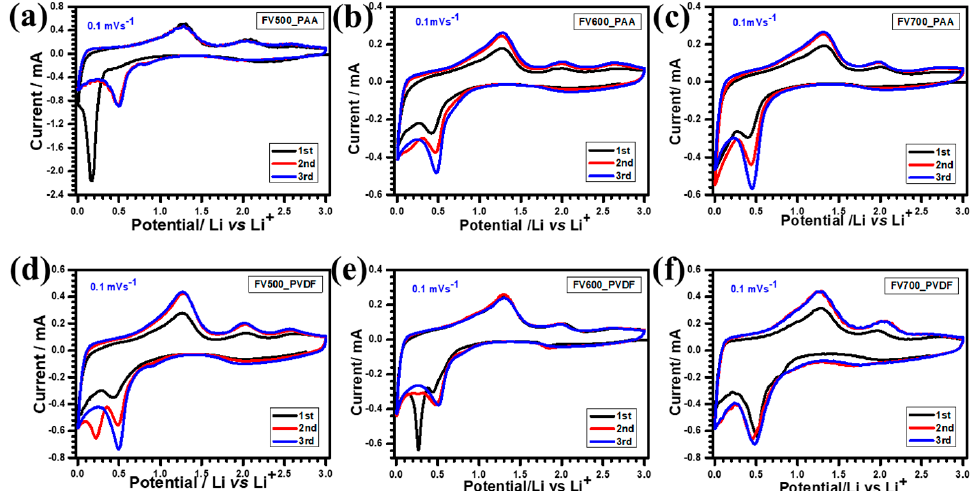
Figure 5. Cyclic voltammetry (CV) curves of ( a – c ) FV500, FV600, and FV700 electrodes fabricated with 35-weight % PAA and ( d – f ) FV500, FV600, and FV700 electrodes fabricated with 5-weight % PVDF binders at a scan rate of 0.1 mVs − 1 within the voltage window of 0.005 V–3.0 V, respectively.